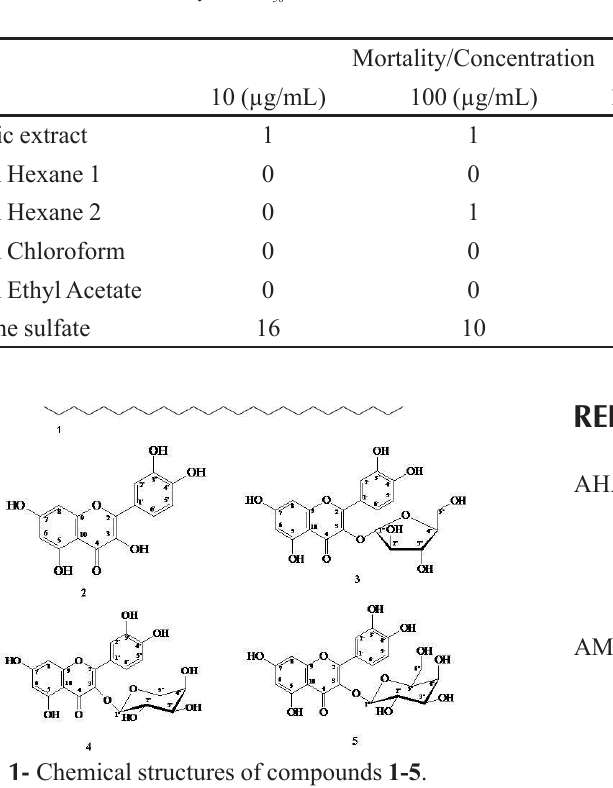
TABLE IV – Artemia salina lethality and LD